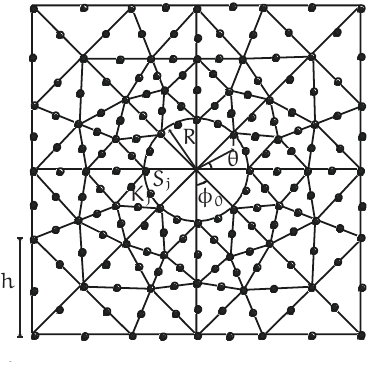
Figure 4.1. The triangulation in the new